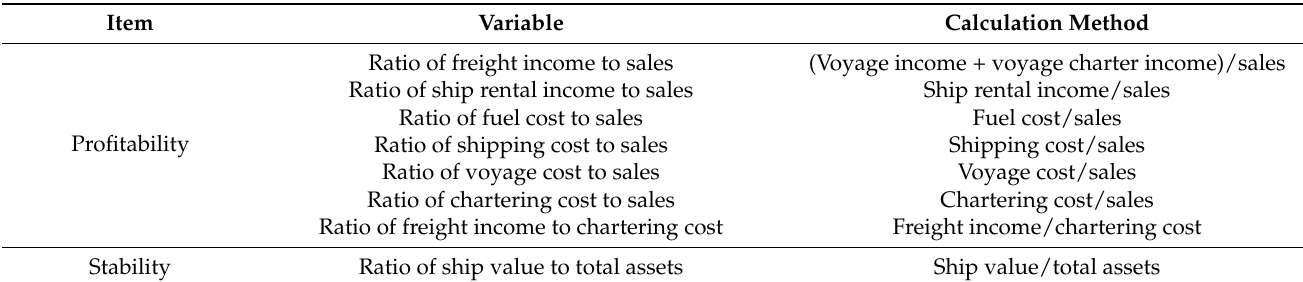
Table 3. Financial indicators considering the characteristics of the shipping industry.